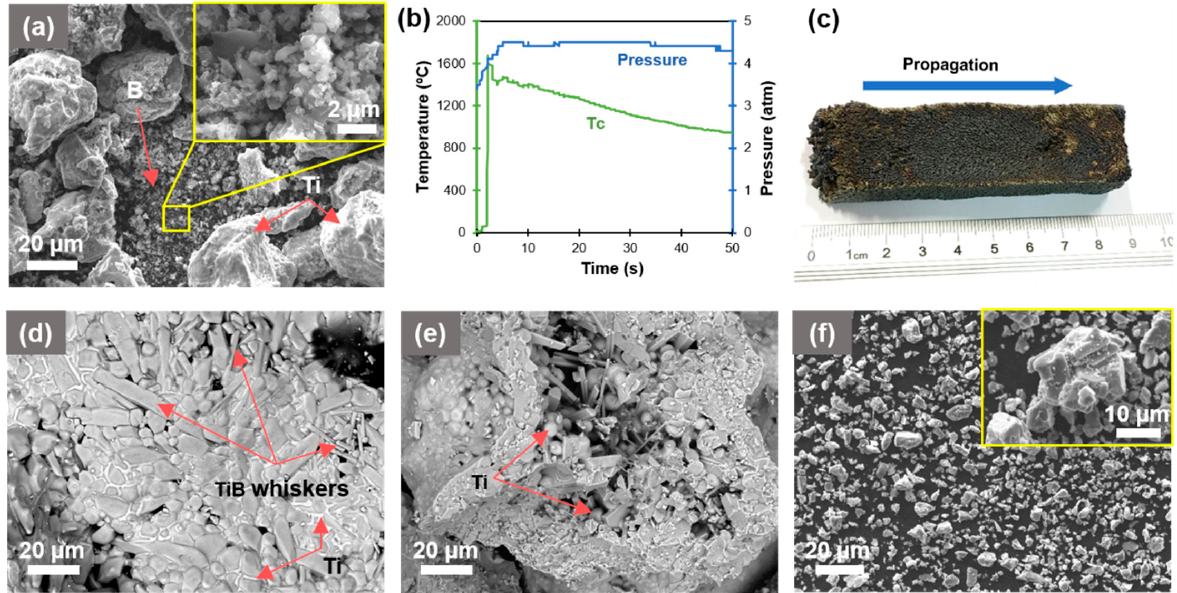
Figure 1. ( a ) SEM image of initial Ti and B powder mixture; ( b ) combustion temperature and pressure evolution; ( c ) high temperature synthesized (SHS) bulk product; ( d,e ) typical examples of SHSed fragments after manual crushing; and ( f ) composite powder after disintegrator milling.